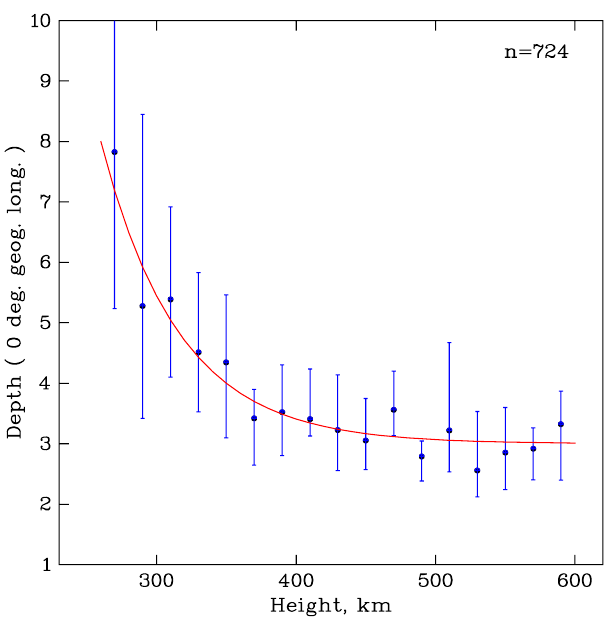
Fig. 7. Longitudinal variation of the magnitude of the density drop in the equatorward trough wall. The format of data presentation corresponds to that of Fig. 6 except that the height is replaced by the geographic longitude. The regression curve fitted to the median values is given in Eq. (6). Note that the results presented in this figure refer to an altitude of 350km. The approximate position of the magnetic north pole is indicated by an